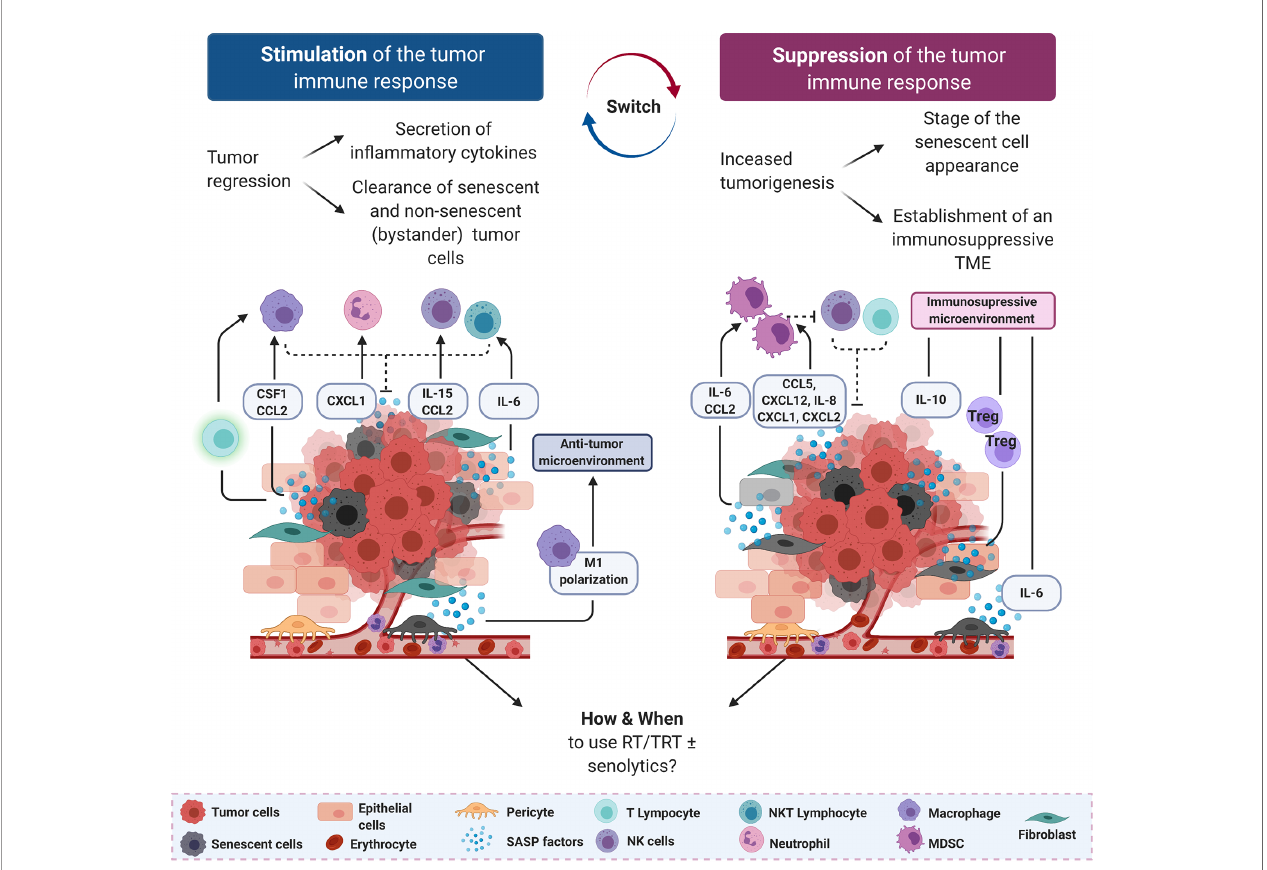
FIGURE 2 | Senescence-associated secretory phenotype (SASP) factors can support or suppress anti-tumor immune responses. On the left, in an immunostimulatory scenario, SASP factors secreted by tumor cells and pericytes drive the recruitment of innate immune cells (macrophages, neutrophils, natural killer (NK) and NK T cells) to mediate the clearance of senescent tumor cells. On the right, in an immunosuppressive scenario, SASP factors secreted mostly by stromal cells recruit immature myeloid cells and myeloid-derived suppressor cells (MDSCs) to dampen the cytotoxic effect of NK cells and CD8+ T lymphocytes. Anti- in fl ammatory mediators, including IL-6 and IL-8, are also secreted by senescent stromal and tumor cells, further increasing the immunosuppressive environment. Senescent cells are represented by a gray cytoplasm, regardless of their origin. CCL, C – C motif chemokine ligand; CXCL, C – X – C motif chemokine ligand; NK natural killer; NKT, natural killer T